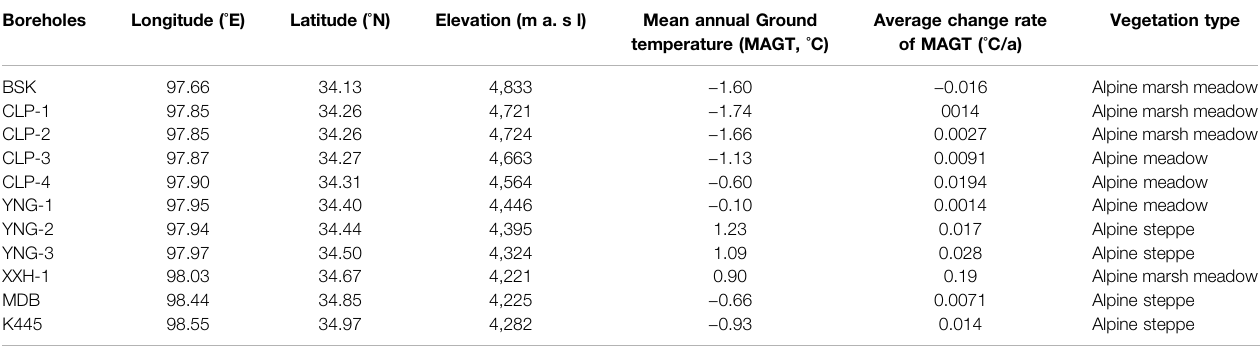
TABLE 2 | Frozen ground temperaturesin boreholes along the National Highway G214 in the HeadwaterArea ofthe Yellow River on the northeastern Qinghai-Tibet Plateau in Southwest China during 2010 – 2016 (modi fi ed from Luo et al., 2018). Boreholes Longitude ( ° E) Latitude ( ° N) Elevation (m a. s